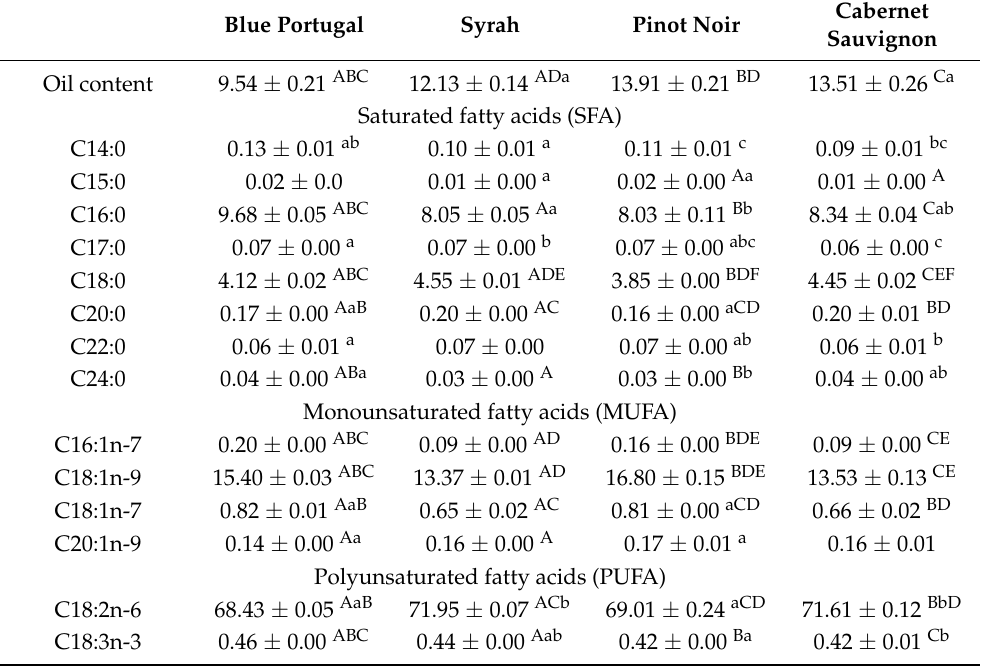
Table 3. Oil content (g oil/100 g dried seed) and fatty acid composition (wt%, weight percent of total fatty acids) of grape seed pomace of four different grape varieties harvested in the Vill á ny wine